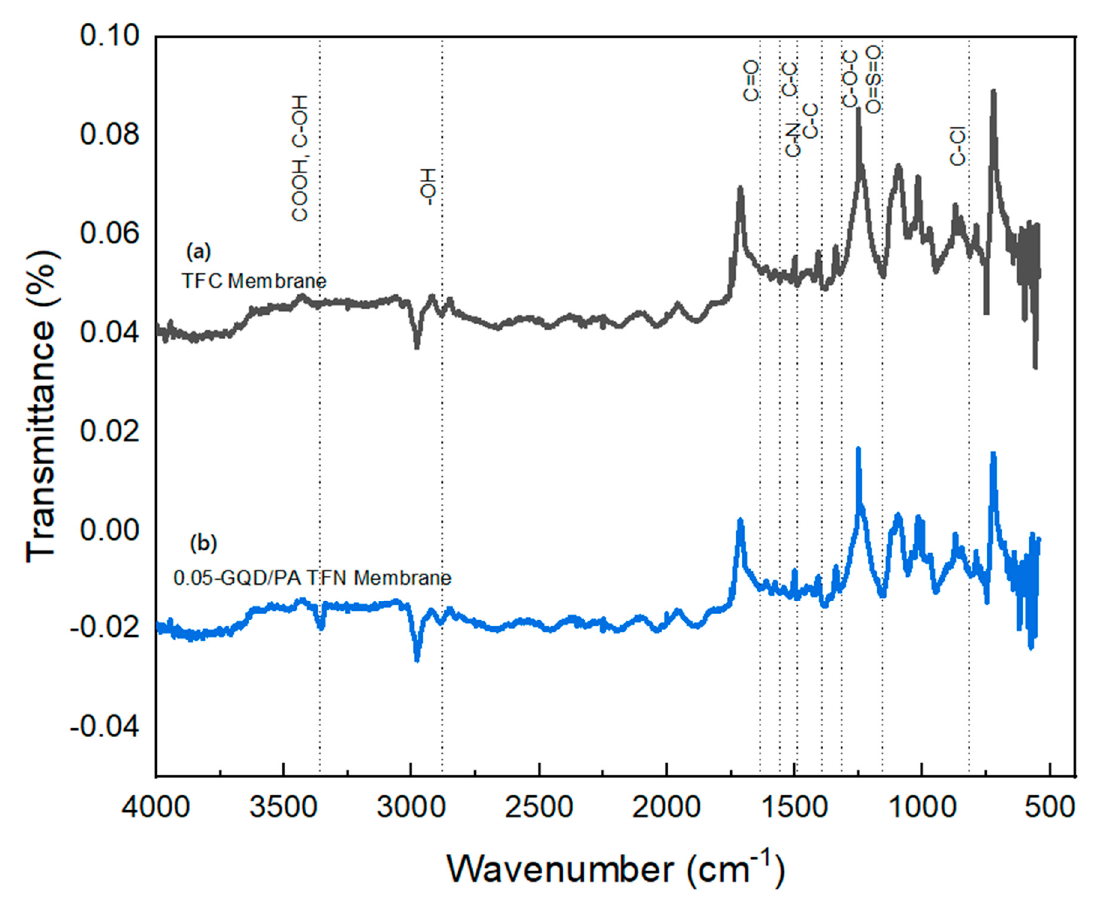
Figure 7. FTIR Images of ( a ) the TFC nanofiber membrane sample and ( b ) the TFN nanofiber membrane sample with 0.05 − GQD/PA TFN.